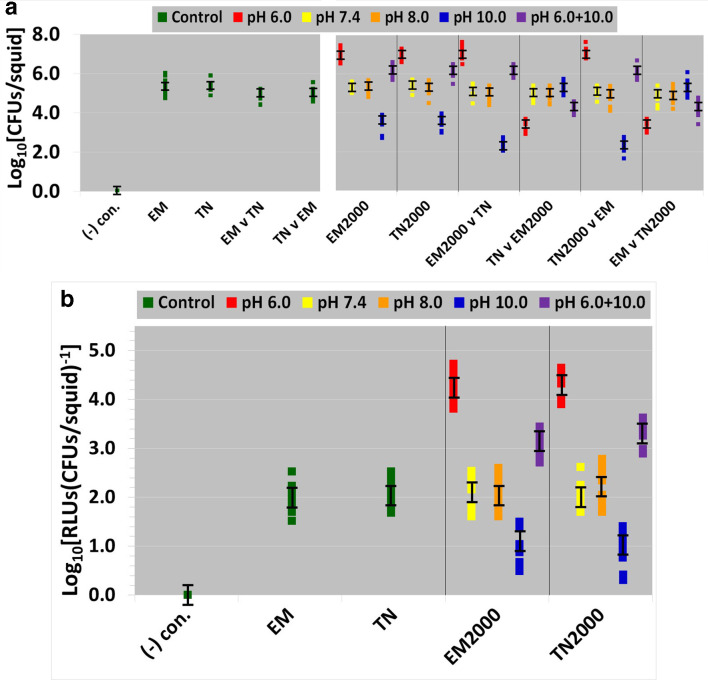
Squid hatchlings were inoculated with 
V. fischeri
. 7a. The squid monocultural and competition data are shown with the ancestral and derived lines. Monocultures only list one participant at the bottom of the diagram, while the competitions list both contestants. For the competitions, the colonization level (log10[CFUs/squid]) shown is for the first contestant of a pair. The second contestant of a pair is the opponent for that particular competition. 7b. Bioluminescence data of squid monocultures (pure cultures). For (a) and (b), the different colors represent either axenic animals (negative control), ancestors (positive controls), or the derived lines (in monoculture and competition). Squares represent individual data points. Key: (-) neg.=negative control, v=versus, EM=ancestral/unevolved 
V. fischeri
 EM, TN=ancestral/unevolved 
V. fischeri
 TN, EM2000=
V. fischeri
 EM evolved for 2000 generations, and TN2000=
V. fischeri
 TN evolved for 2000 generations. There are no competitions in (b). For (a) and (b), error bars represent least significant difference (LSD) of the mean.